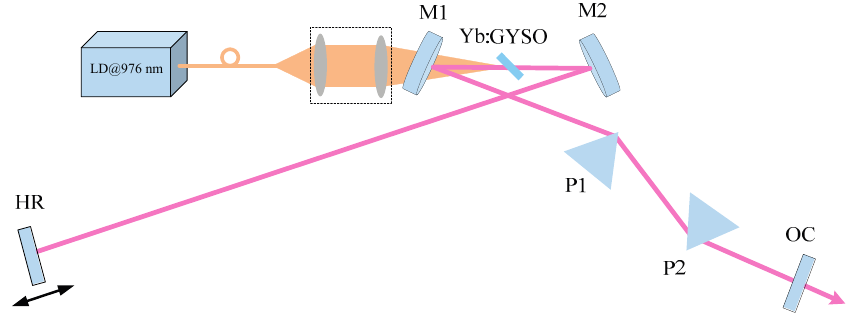
Figure 1. Layout of the Kerr-lens mode-locked Yb:GYSO oscillator. LD: laser diode; M1 and M2: concave mirrors with ROC of 75 mm; P1 and P2: SF6 prisms; HR: high reflection mirror; OC: output coupling mirror of 0.8%